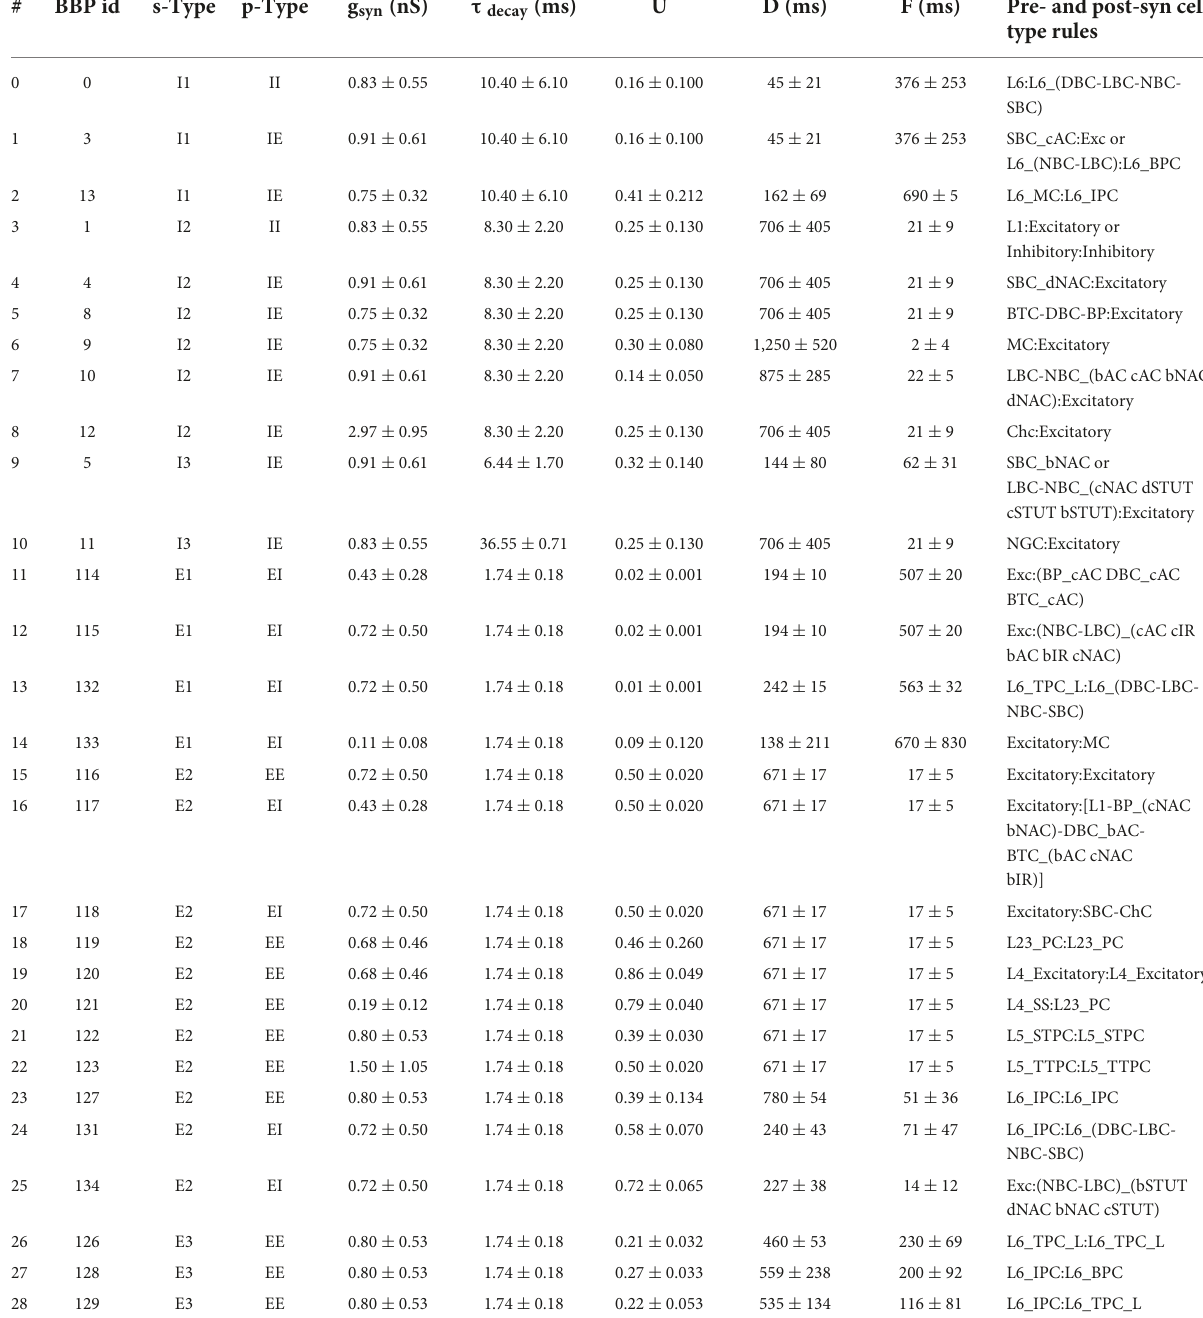
TABLE 1 Synaptic properties, s-type, p-type, and rules for each class of connections implemented in